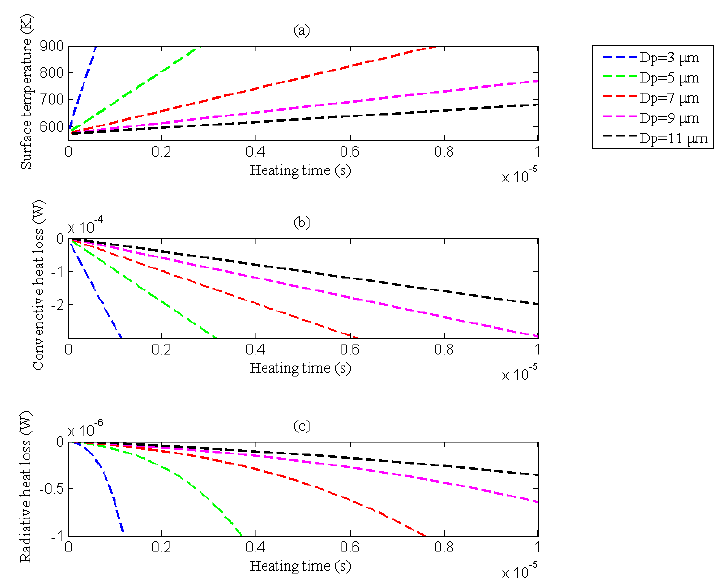
Figure 5. The calculated curves of temperature rise (heating rate) and convective and radiative heat losses of graphite under laser radiation absorption. ( a ) Surface temperature rise; ( b ) Convective heat loss; ( c ) Radiative heat loss.